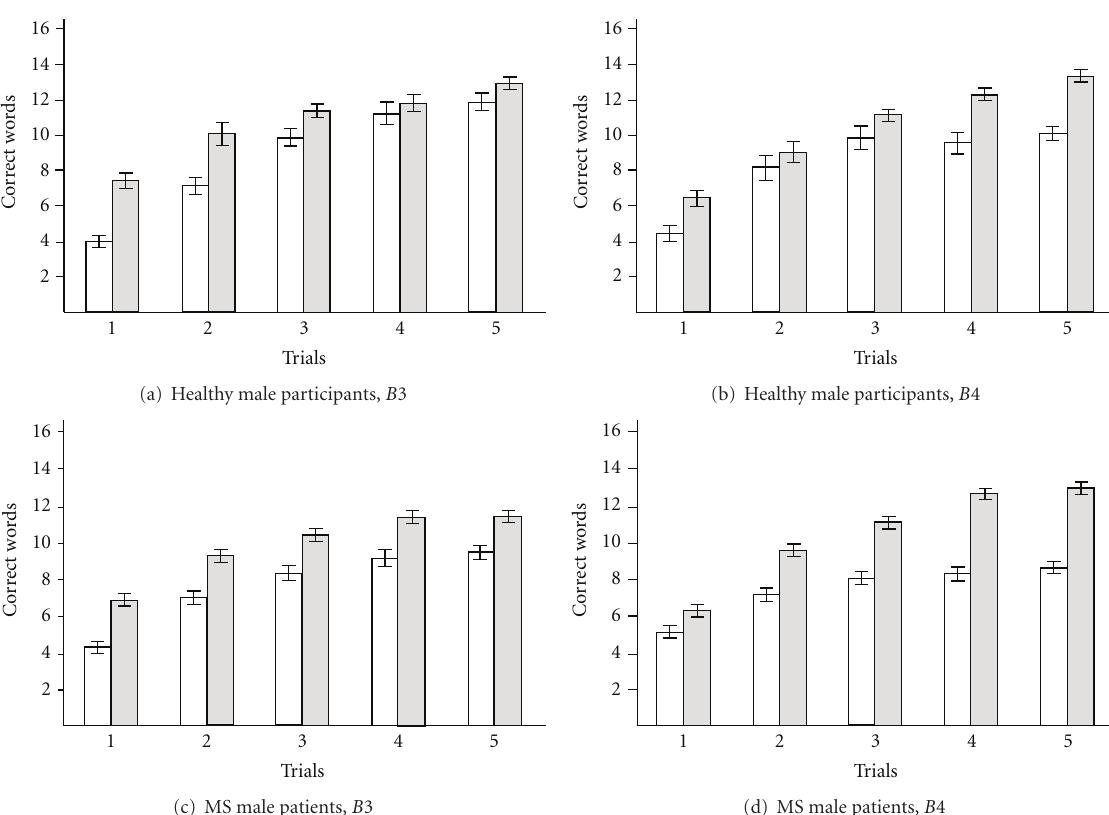
Figure 4: Cluster analysis using B 3 or B 4 in males. (a) Healthy male participants: clustering using B 3 only, cluster referring to lower memory functioning (9 cases) and cluster referring to higher memory functioning (11 cases). There is no overlap between these B 3 clusters. (b) Healthy male participants: clustering using B 4 only, cluster referring to lower memory functioning (5 cases) and cluster referring to higher memory functioning (15 cases). There is no overlap between these B 4 clusters. (c) MS male patients: clustering using B 3 only, cluster referring to lower memory functioning (48 cases) and cluster referring to higher memory functioning (51 cases). There is no overlap between these B 3 clusters. (d) MS male patients: clustering using B 4 only, cluster referring to lower memory functioning (59 cases) and cluster referring to higher memory functioning (40 cases). There is no overlap between these B 4 clusters. Cluster referring to lower memory functioning—white bars, cluster referring to higher memory functioning—gray bars. Each bar represents mean ±